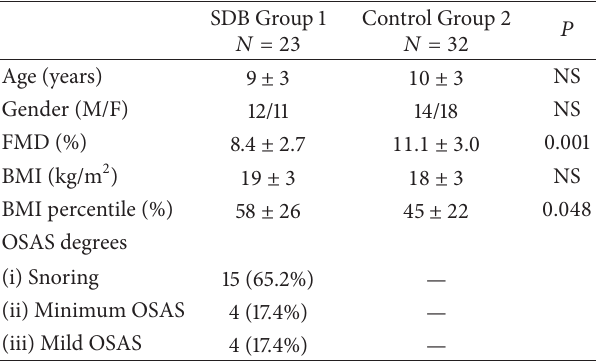
Table 1: General characteristics of study